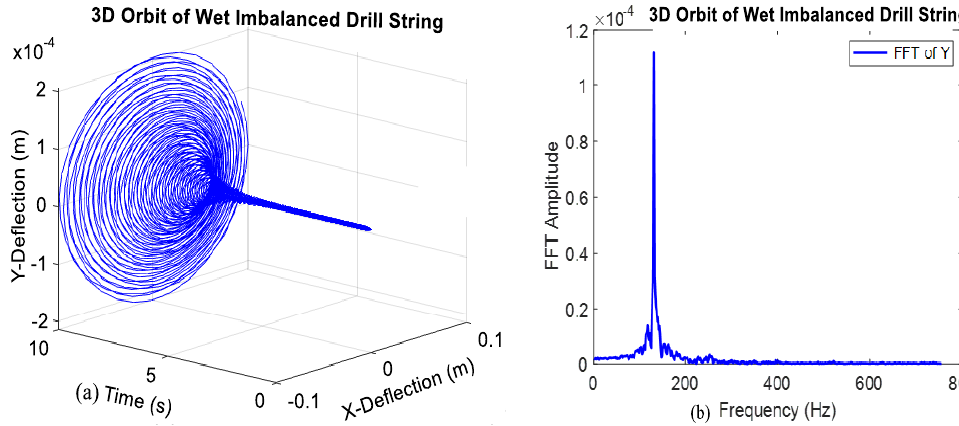
Figure 9. Response of the imbalanced drill string system immersed in an inviscid fluid at the first critical speed. ( a ) 3D imbalance response orbit in fluid; ( b ) FFT response of drill string in fluid